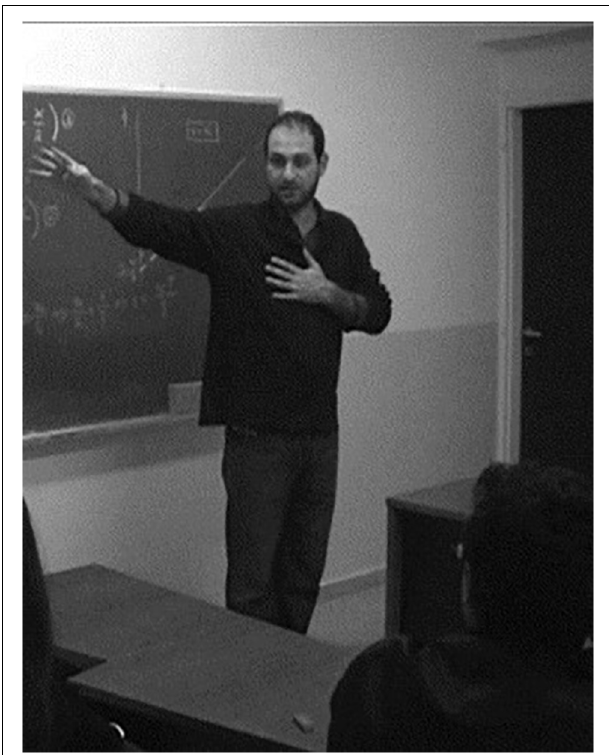
FIGURE 12 | Teacher as a particle in space.